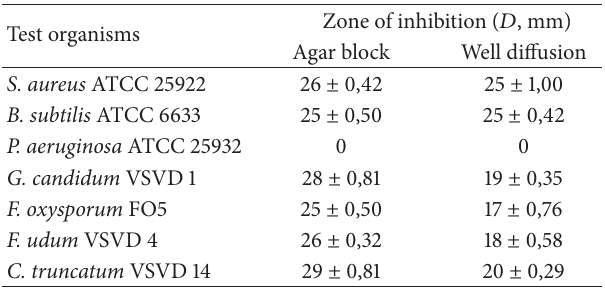
Table 1: Antimicrobial activity of the endophytic actinomycete isolate